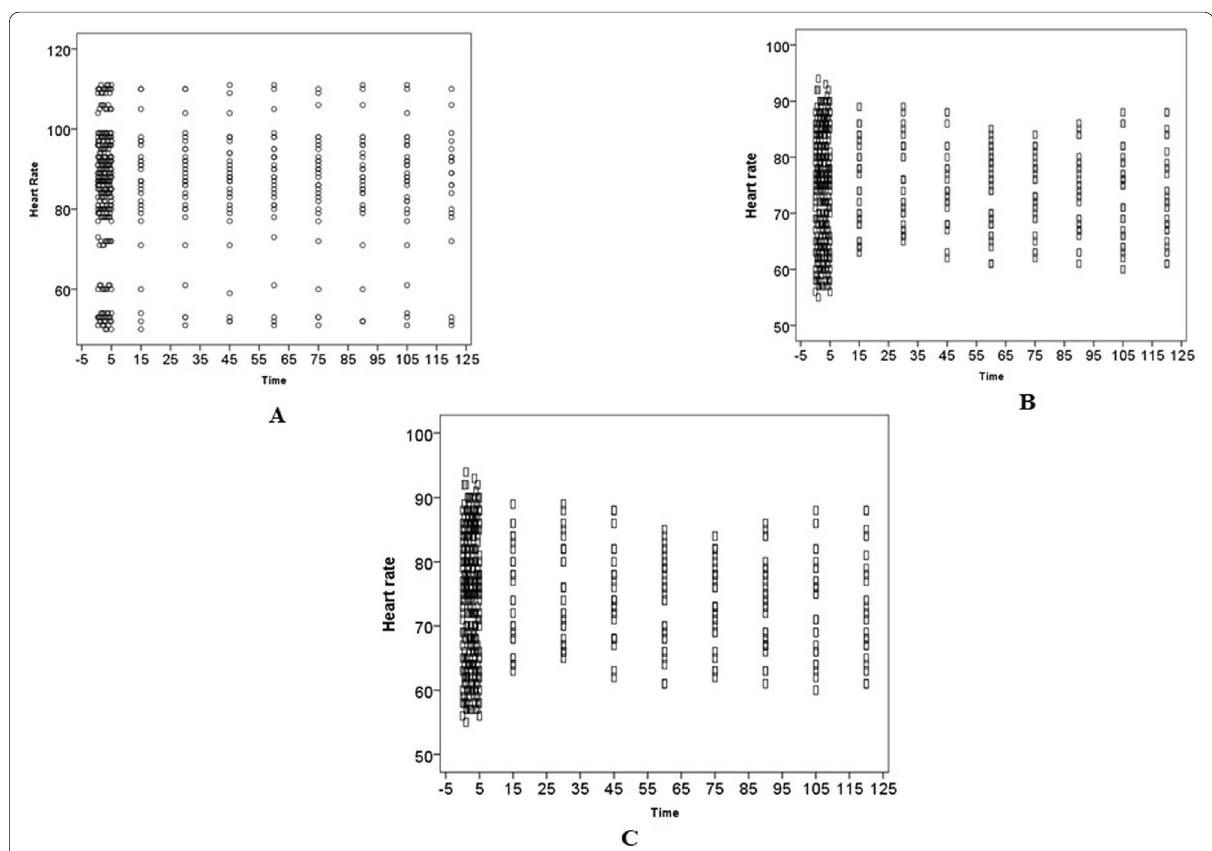
Fig. 2 Graph showing trends of heart rate in post-extubation